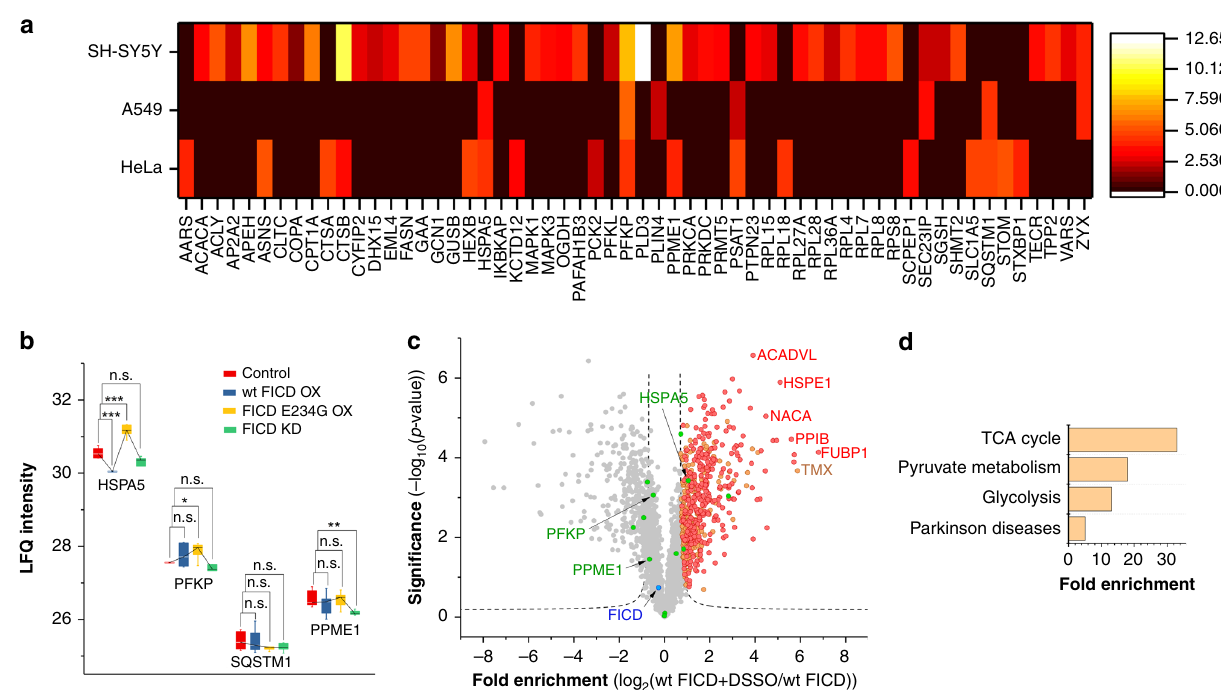
Fig. 3 AMPylation in cancer cell lines. a Heatmap representation of enriched proteins identi fi ed in cancer cell lines. Colour represents distance to zero of enriched proteins from respective volcano plot (FDR 0.05, s0 0.3; n = 8 or 9). b FICD-dependent AMPylation. Changes in AMPylation on selected proteins (those identi fi ed in HeLa cells from Fig. 1e) upon FICD overexpression (OX) or siRNA-mediated knock-down in (KD) HeLa cells. Statistical signi fi cance was tested using two-tailed Student ’ s t -test; * P < 0.05 ** P < 0.01,*** P < 0.001. c FICD – interacting proteins. Volcano plot representing FICD interacting proteins identi fi ed in the pull-down experiment of his tag labelled FICD and DSSO cross-linking reagent (FDR 0.01; s0 1.5; n = 3). Green circles represent proteins identi fi ed as AMPylated in HeLa cells. Red circles represent hits overlapping with parallel experiment with FICD E234G mutant. Orange circles